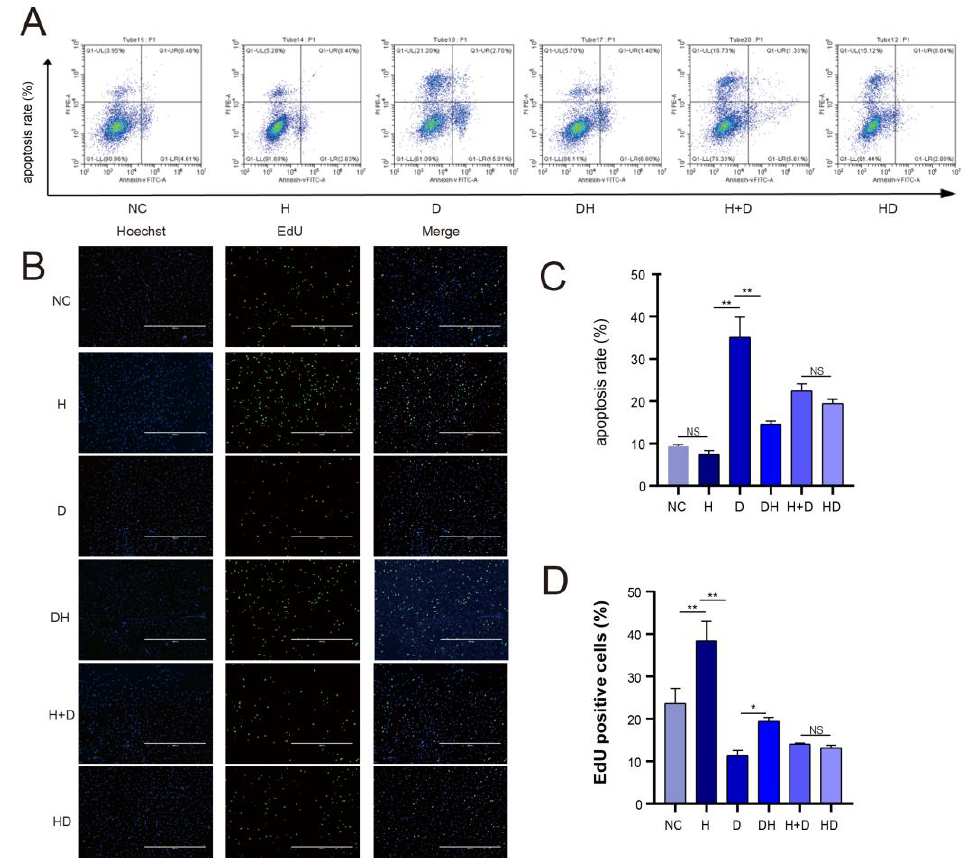
Figure 2. Effect of HMB on myoblast apoptosis and proliferation. ( A ) Flow cytometry plots; ( B ) EdU staining (scale: 400 µm); ( C ) Bar graph depicting cell apoptosis rate of each group; ( D ) Bar graph illustrating the frequency of EdU-positive cells in each group; n = 3, * p < 0.05, ** p < 0.01, NS (No Significant).